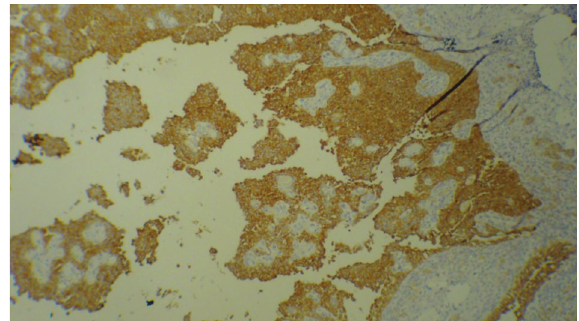
Figure 4: Immunohistochemical labeling of tumor cells with